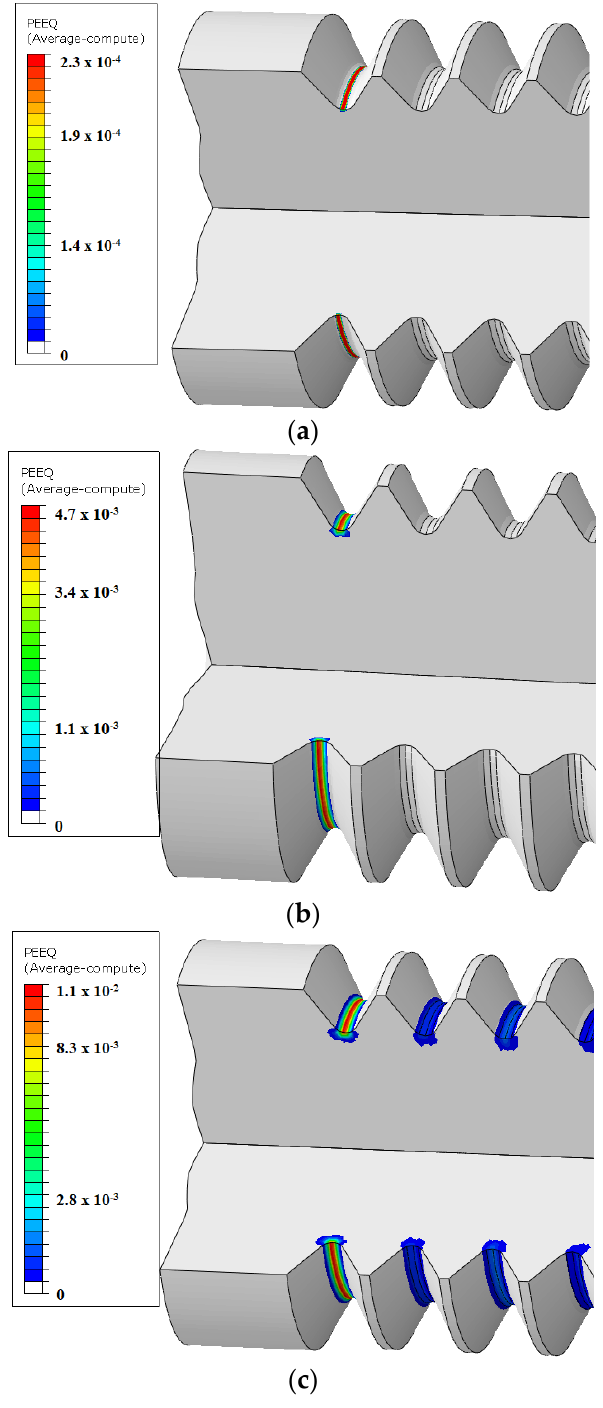
Figure 15. Strain (mm/mm) for threaded specimens without nut interface at a maximum nominal stress of ( a ) 440.6 MPa (50% of the yield strength), ( b ) 616.8 MPa (70% of the yield strength), and ( c ) 793 MPa (90% of the yield strength).